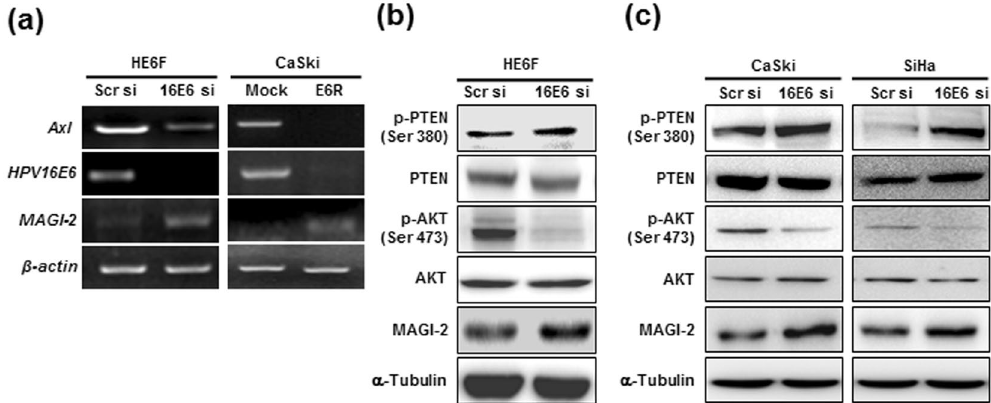
Figure 3. The MAGI-2/PTEN/AKT signalling pathway is involved in HPV16E6-mediated Axl expression. ( a ) MAGI-2 expression by knockdown of endogenous HPV16E6 was confirmed by RT-PCR in HE6F (left panel) and CE6R (right panel) cells compared to corresponding mock controls. ( b , c ) Expression of phosphorylated AKT and PTEN was analysed by western blot analysis in HPV16E6-knocked down (siRNA) HE6F ( b ), CaSki, and Siha cells ( c ). Upregulation of protein expression of MAGI-2 by HPV16E6 siRNA in HE6F, CaSki, and Siha cells was confirmed by western